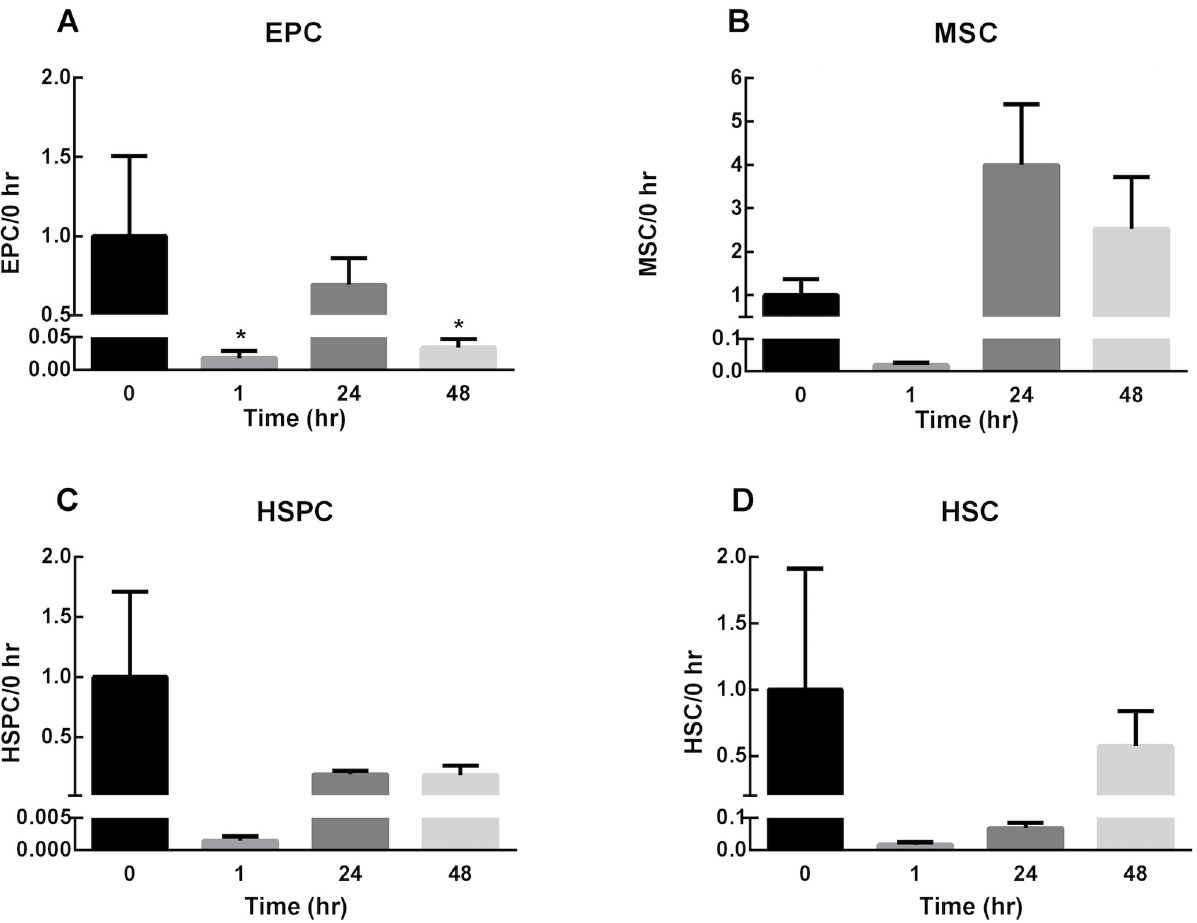
Fig 7. Circulating progenitor cell numbers. Flow cytometry counts of EPCs, MSCs, HSPCs, and HSCs (as defined in Table 1), reported in fold change versus time 0. Blood was collected from mice immediately (0hr), 1, 24 and 48hrs after ear wounding. Bars represent mean fold change ± SEM, n = 3. � represents p < 0.05.